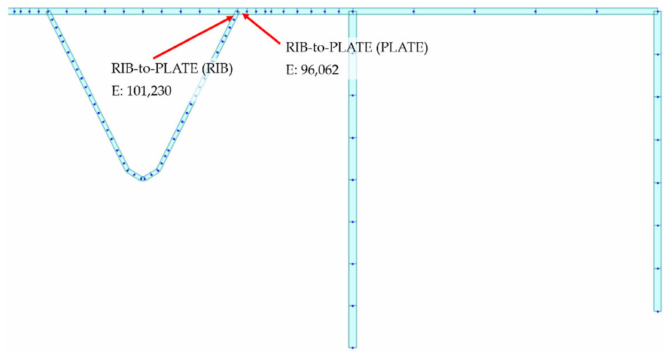
Figure 25. Rib-to-Plate detail location in the finite element